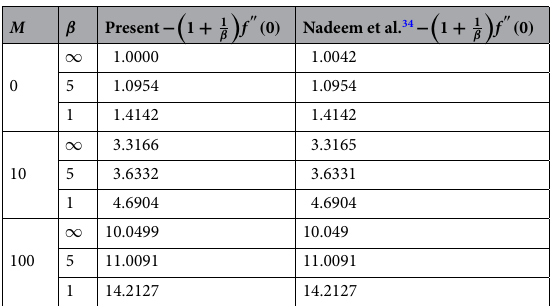
Table 4. Comparison of numerical values of magnitude of skin friction coefficient in x -direction against M , β (cid:31) Nr A 0 . for m = = = =